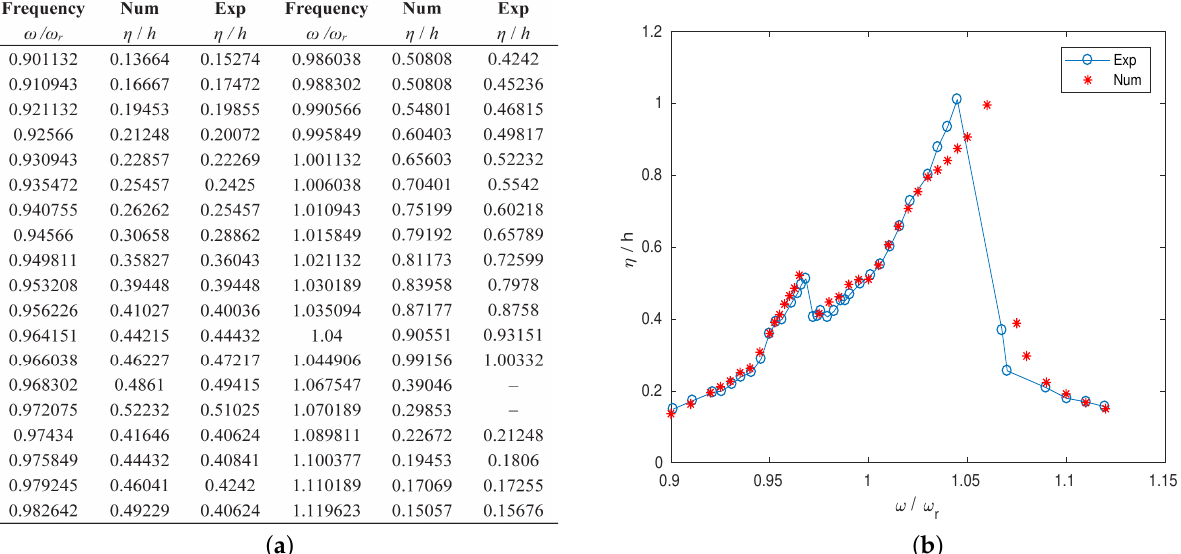
Figure 3. Variation of the maximum transient amplitudes divided by the water depth with excitation frequencies around the first natural frequency. ( a ) table; ( b )